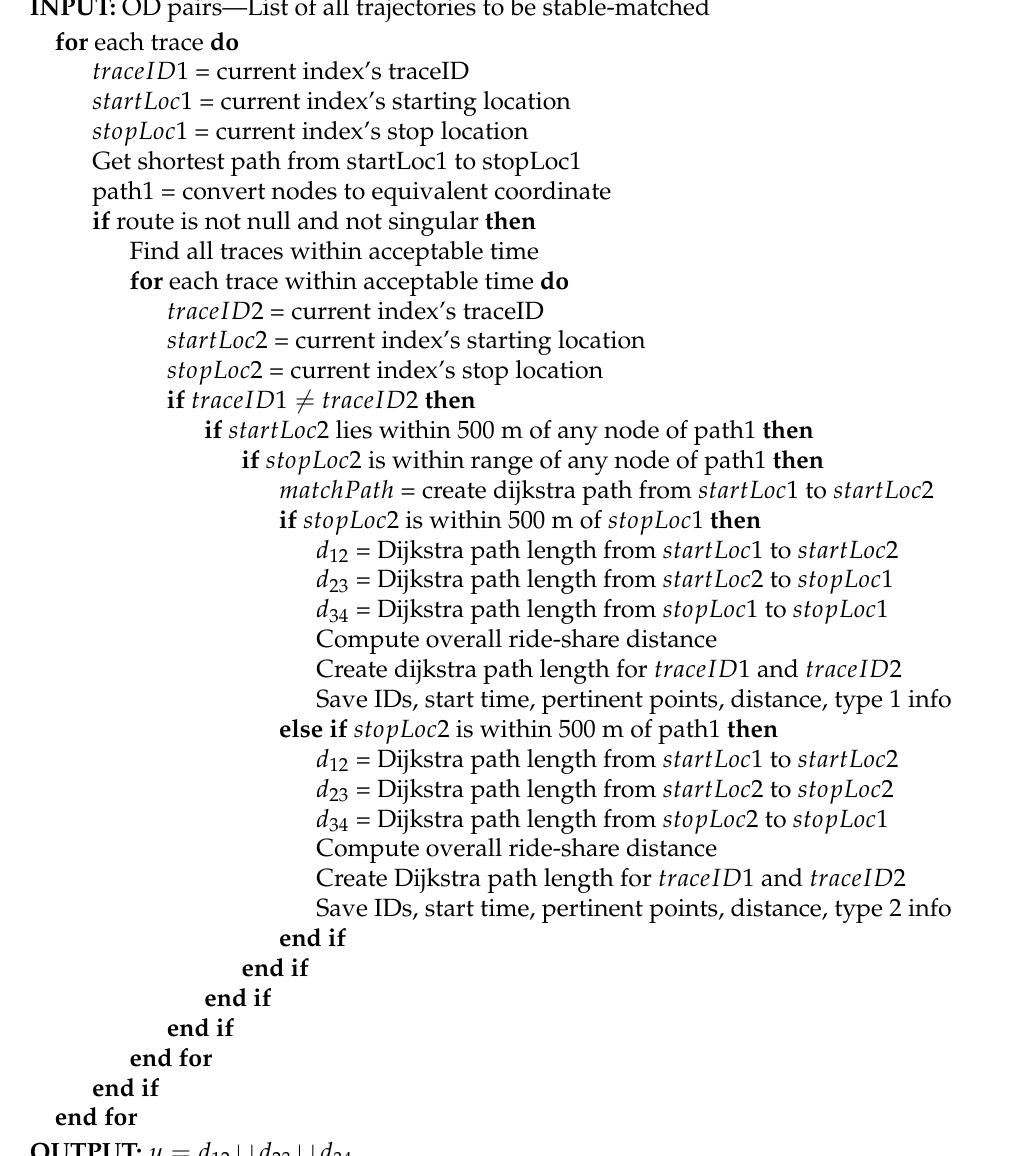
Algorithm 1 Stable Matching All Possible Pairs.